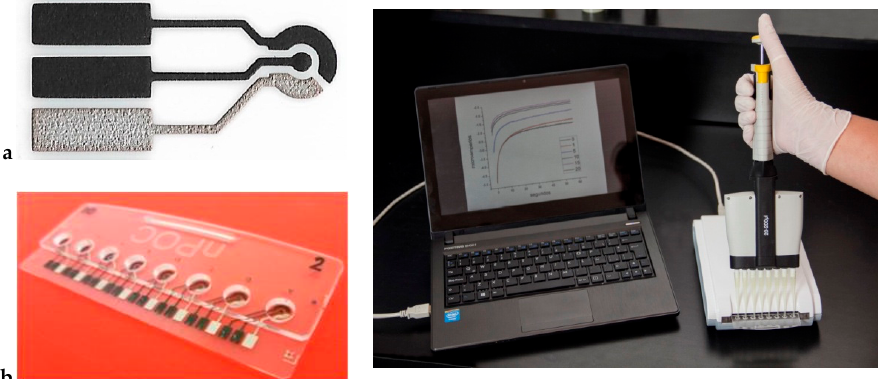
Figure 1. ( a ) Screen-printed electrodes; ( b ) electrochemical cells; ( c ) electrochemical